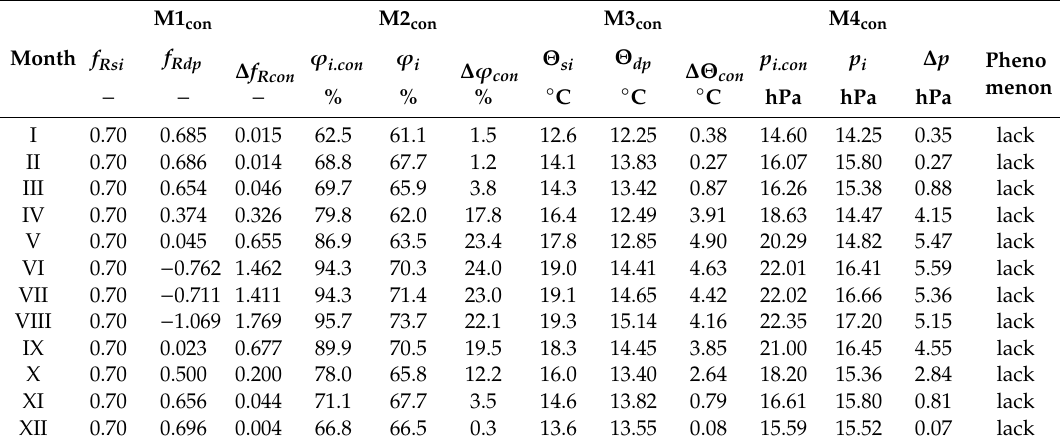
Table 8. Parameters for determining the conditions of surface condensation and the state of the phenomenon for four